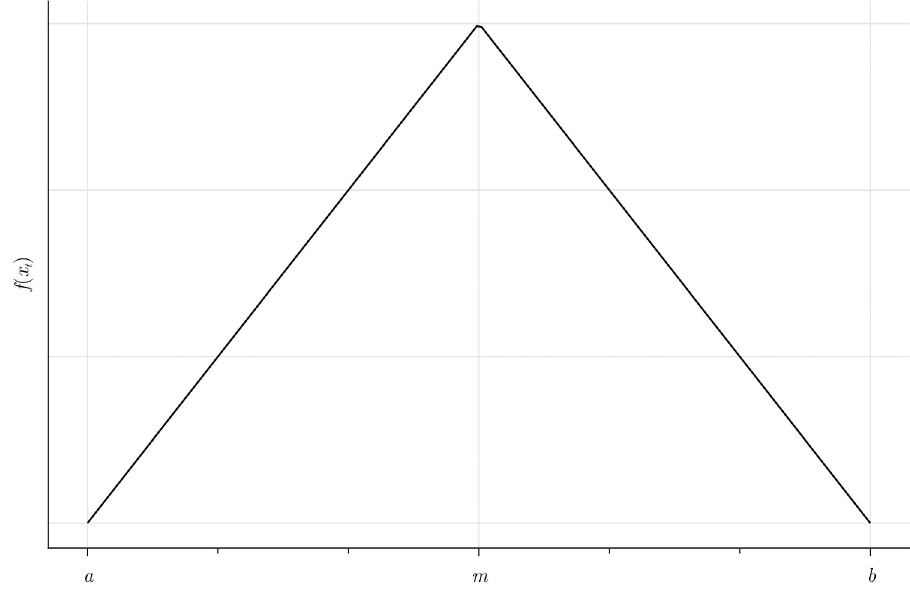
Fig 2. Density function of the triangular distribution for a generic social